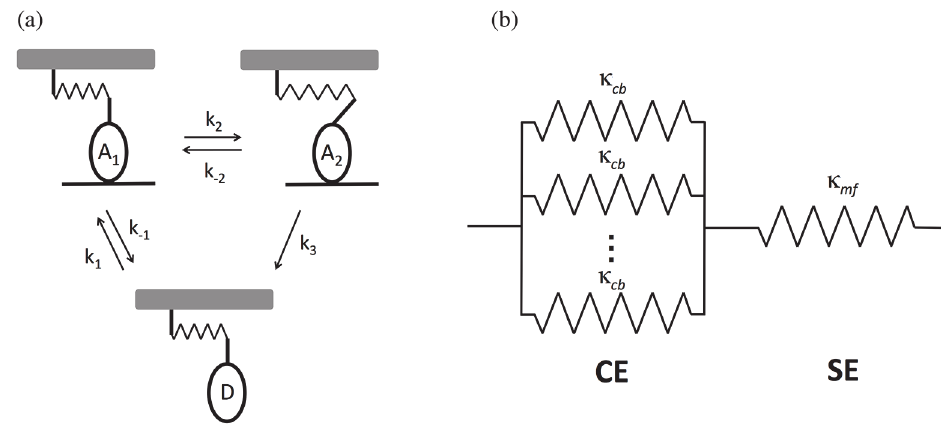
Fig 9. Model of the half-sarcomere. (a) Individual cross-bridges are linearly elastic elements that pass through three states: two attached states (A 1 and A 2 ) and a detached state (D). The transition from A 2 to D is irreversible, and the transition from A 1 to A 2 corresponds to the powerstroke. (b) Model of the half-sarcomere. The half-sarcomere was modeled as a cross-bridge element (CE), consisting of cross-bridges attached in parallel, which is in series with the series element (SE), which represents the myofilament